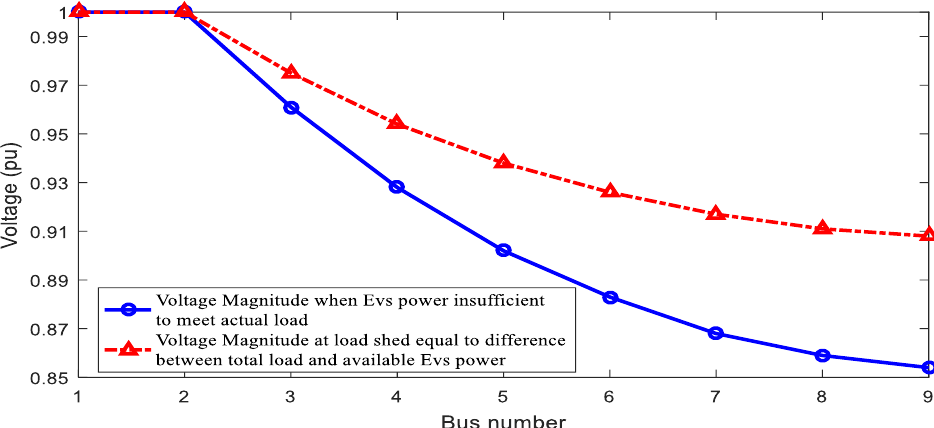
Figure 6. Voltage profile at hour 16 before and after load shedding.